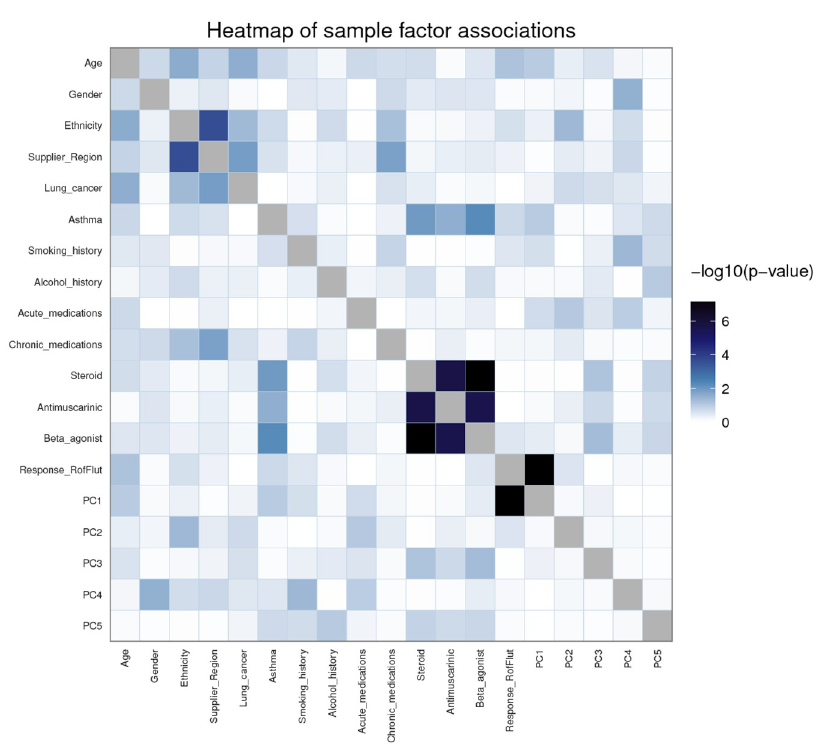
Fig 4. Heat map showing the results of patient demographic correlation with TNF α release from stimulated human lung parenchyma biopsies following roflumilast and fluticasone co-treatment. Each parameter is assessed in relation to each other, the principal components (PC) driving variation in the data and to the organoculture assay response. Each area within the heatmap denote a p-value of association between pairs of variables from statistical tests. The statistical tests utilised depends on the property of the factors: for an association between two categorical factors, a chi-squared test was used. For an association between a categorical and a continuous factor, ANOVA was used. For an association between two continuous factors, a Spearman correlation test was used. In all cases, the resulting p-value was transformed as -log10(p) before being visualised in the confounding factors